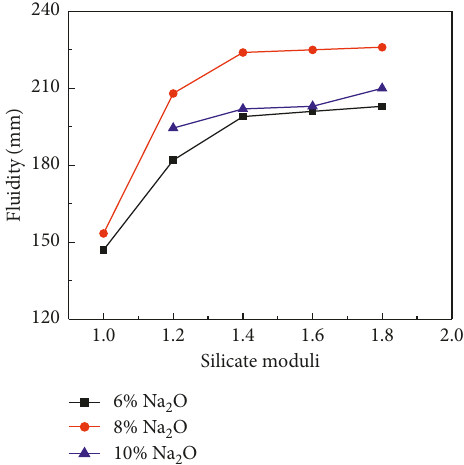
Figure 2: The effects of the silicate moduli and Na the fluidity of AAS